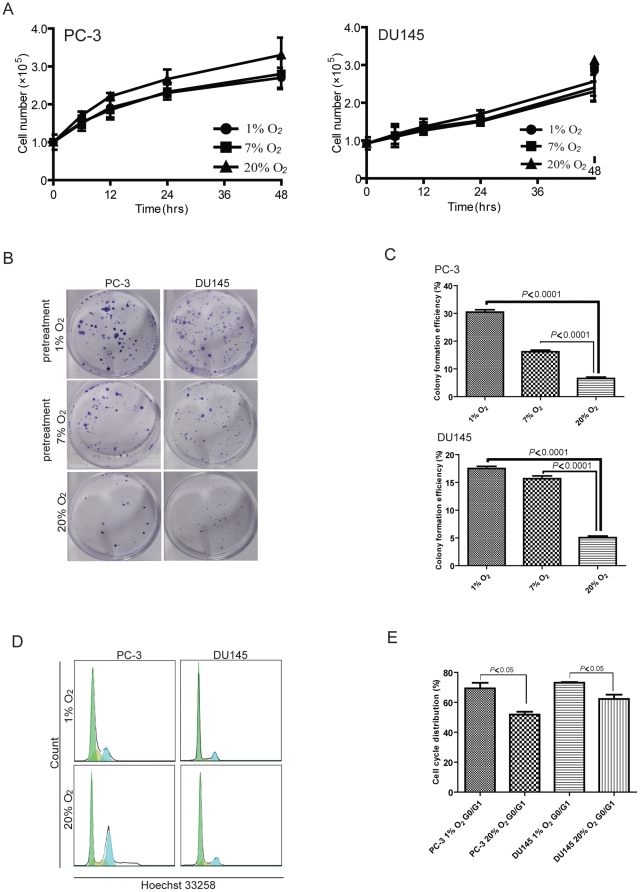
Hypoxic effects on cell proliferation, colony formation and cell cycle.(A) Cell proliferation curves show no statistical difference for cell growth under different oxygen tensions (P>0.05). (B) Colony formation assay for both cell lines shows more colonies in the cells pre-treated at 7% O2 for 48 hours and even more colonies in the cells pre-treated under 1% O2 (C) Histograms for the colony formation efficiency shows statistically higher efficiency in the cells pre-treated under hypoxia (7% or 1% O2) for both cell lines (P<0.0001). (D) Flow cytometry shows extended G0/G1 stage for both cell lines which have been cultivated under 1% O2 for 48 hours, in comparison to the cells always kept under normoxia. (E) Statistical analyses reveal significantly extended G0/G1 stage in the cells cultivated under hypoxia for both cell lines (P<0.05).